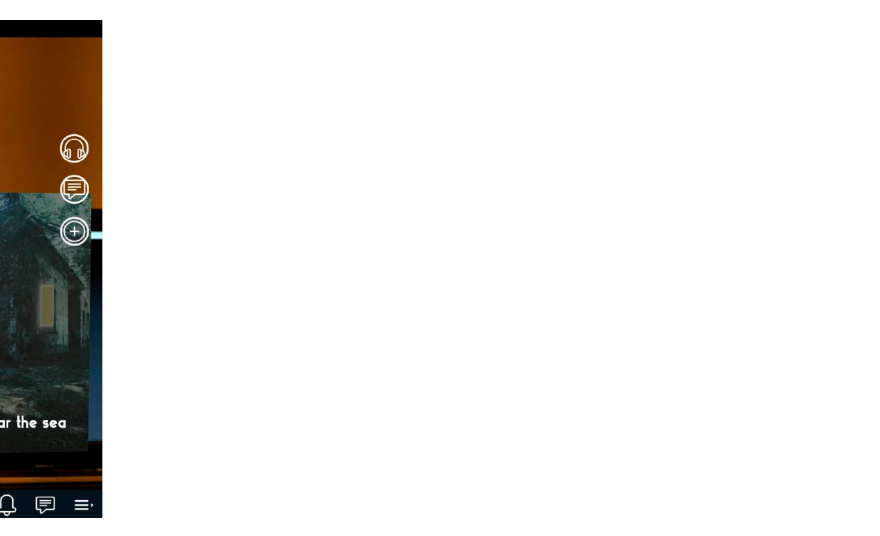
Figure 13. Enabled view of floating keywords surrounding the targeted exhibit behaving as buttons that narrate the corresponding visitor’s comment once it is clicked.